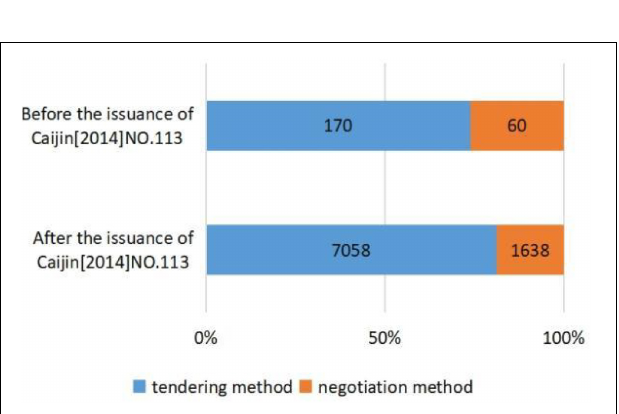
FIGURE 2 | Distribution of procurement models selection for different industry